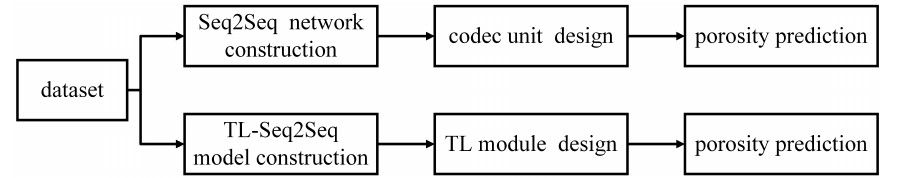
Figure 8. Flowchart of the porosity prediction based on TL-Seq2Seq